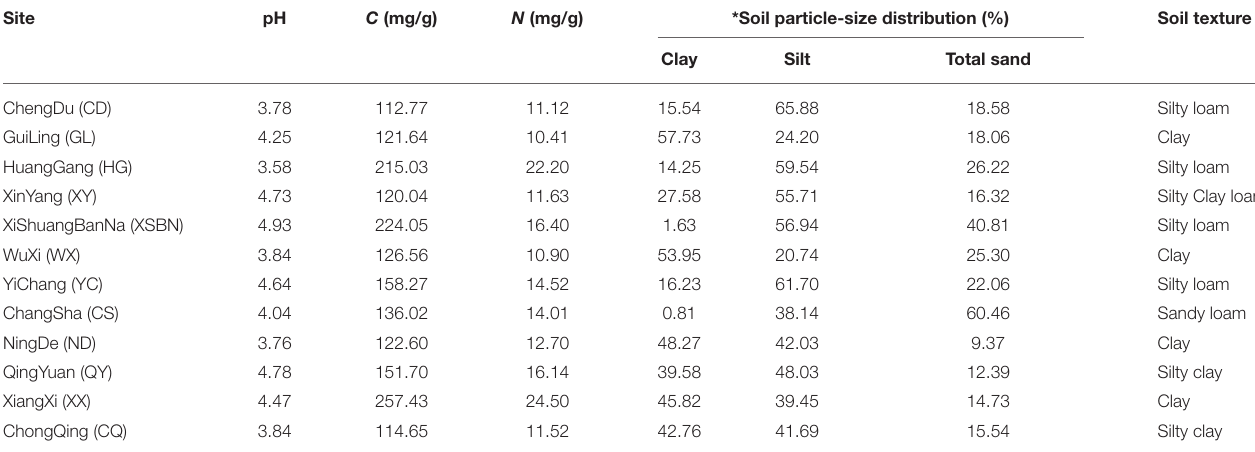
TABLE 1 | Soil properties of tea plantations at the selected 12 countries in China. Site pH C (mg/g) N (mg/g) *Soil particle-size distribution (%) Soil texture Clay Silt Total